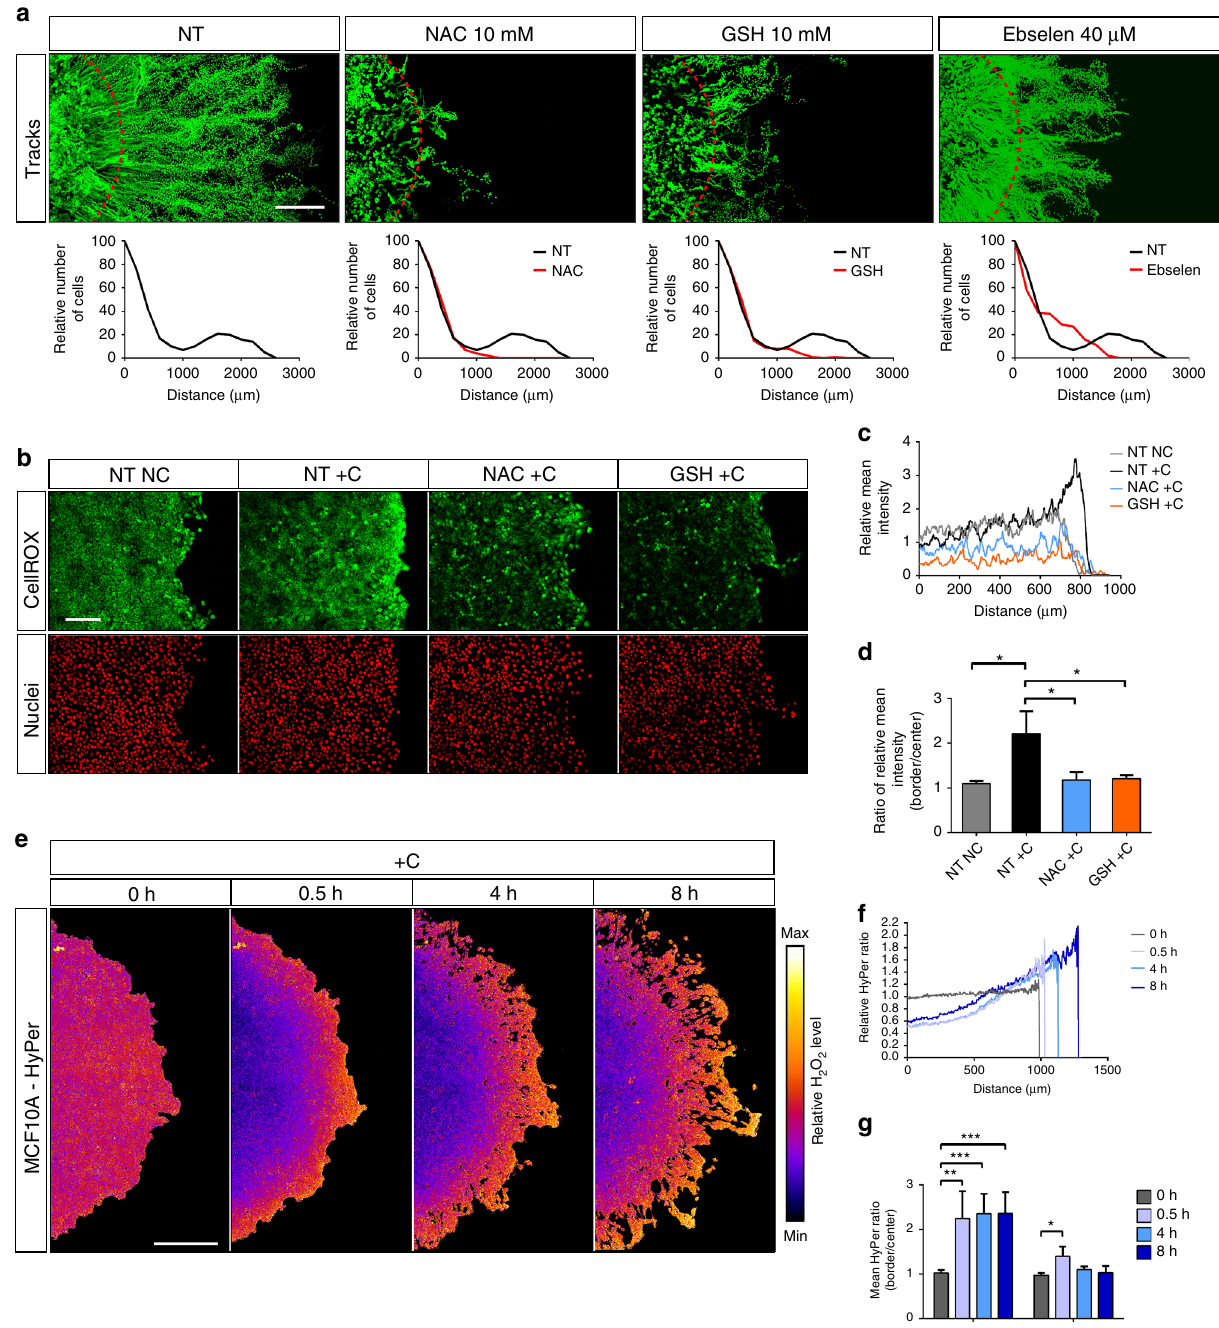
Fig. 4 ROS are essential players of aerotaxis. a Tracking and redistribution of con fi ned wt MCF10A cells upon treatment with antioxidants. NT non-treated, NAC N-acetyl-cysteine, GSH reduced glutathione; Ebselen. Top panels: cell trajectories over 48 h. Dashed red lines indicate the border of the cell clusters at 0 h. Bottom panels: relative distribution of MCF10A cells at the edge of the cluster at 48 h. These experiments demonstrate that antioxidants dampen aerotaxis. Scale bar, 500 µ m. b Analysis of ROS accumulation with the chemical probe CellROX green unveils the ROS gradient generated under con fi nement (2 h): H2B-mCherry expressing MCF10A cells were con fi ned ( + C) or not (NC) and either not treated (NT) or treated with NAC (10 mM), GSH (10 mM) or Ebselen (40 µ M). Images are representative of 3 independent experiments. Scale bar, 200 µ m. c Mean CellROX fl uorescence intensities (normalized to the NT NC condition) along the radius of the cell cluster were assessed from ( b ). d Border to centre ratios of CellROX green fl uorescence intensity (mean ± SD; n = 3 independent experiments). These experiments demonstrate that ROS speci fi cally accumulate at the edge of the cell cluster under con fi nement, a process that is abolished upon treatment by antioxidants. e Assessment of H 2 O 2 concentrations with MCF10A cells expressing HyPer-3 under con fi nement. Relative H 2 O 2 level is represented in pseudocolors (see Methods for details). Scale bar, 500 µ m. f Relative H 2 O 2 levels (normalized to the t = 0 h level) along the radius of the cell cluster computed from panel ( e ). g Mean border to centre ratios of HyPer-3 and HyPer-red- C199S signals calculated from panel ( e ) and Supplementary Fig. 10a ( n = 4). *** P < 0.001, ** P < 0.01, * P < 0.05 by two-tailed Student ’ s t -test. NC uncon fi ned, + C con fi